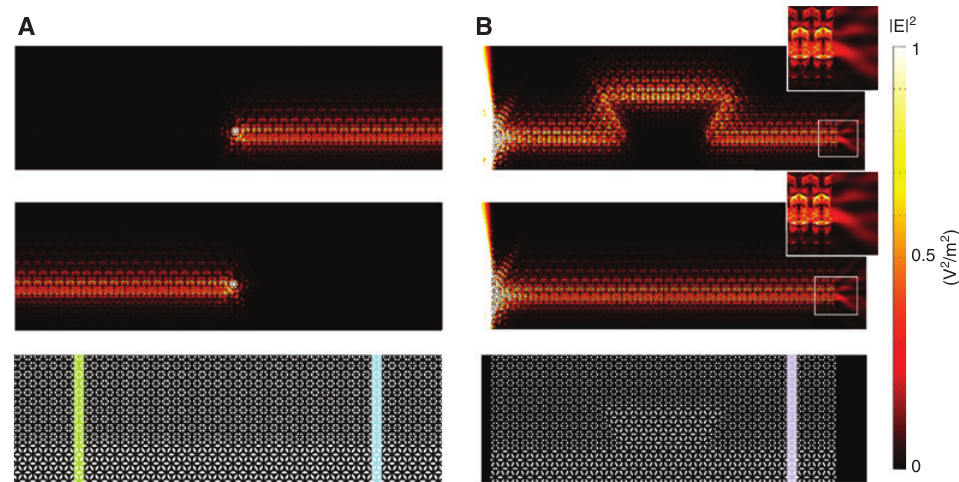
Figure 4: Spin-dependent directional emission and robust propagation past 120 ° bends. (A) The photonic topological insulator (PTI) is excited using a chiral source emitting at 184 THz placed near the interface and rotating clockwise (top) and counter-clockwise (middle) for the material distribution shown in the bottom panel. The emission direction depends strongly on the chirality of the emitter, which clearly demonstrates spin-dependent directional emission for emitters placed at the PTI interface. (B) Field propagation at 184 THz through four 120 ° bends (top) for the material distribution shown in the bottom panel compared to propagation along a straight channel (middle). This demonstrates the backscattering-robust propagation along the PTI interface. The colour map is truncated at | E | 2 = 1 V 2 /m 2 as the field strength at the source diverges.